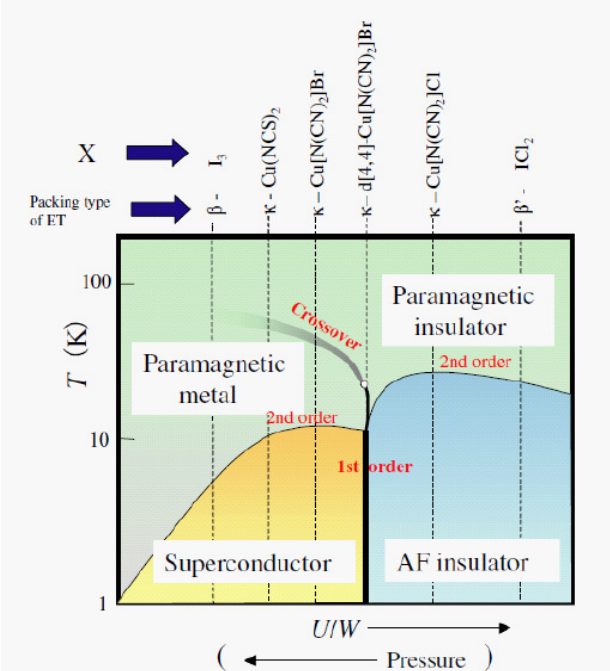
Figure 2. Conceptual electronic phase diagram of the dimer-Mott system based on κ -type and β -type salts consisting of BEDT-TTF molecules. The salts with κ -type structure with different counteranions and other dimerized structure salts are indicated in the phase diagram